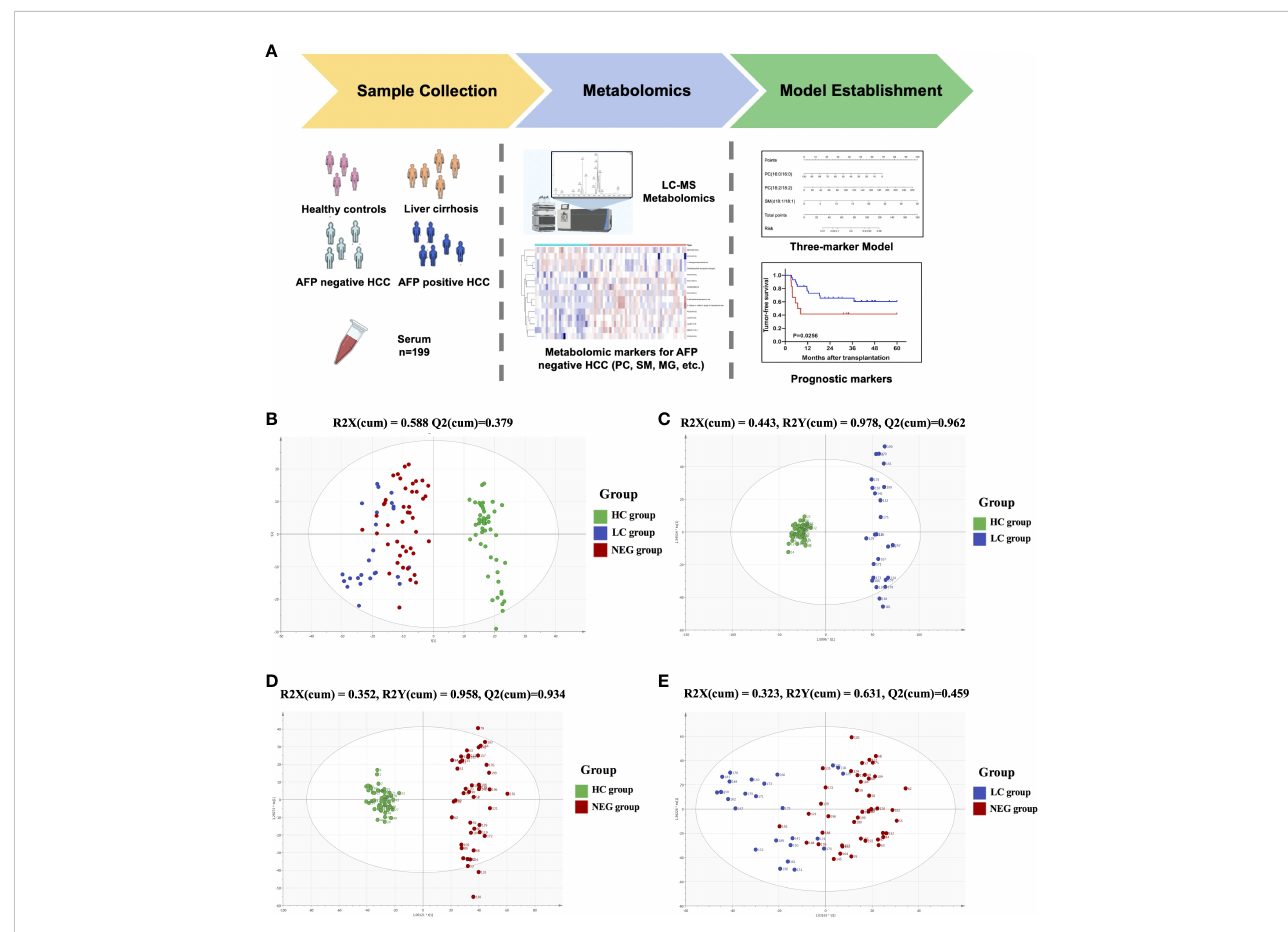
FIGURE 1 The metabolomics pro fi ling for plasma samples. (A) General work fl ow for this study. (B) PCA score plot for 52 healthy controls, 25 liver cirrhosis patients, 122 HCC patients and 15 quality controls. (C) OPLS-DA score plot for HC and LC group. (D) OPLS-DA score plot for HC and NEG group. (E) OPLS-DA score plot for LC and NEG